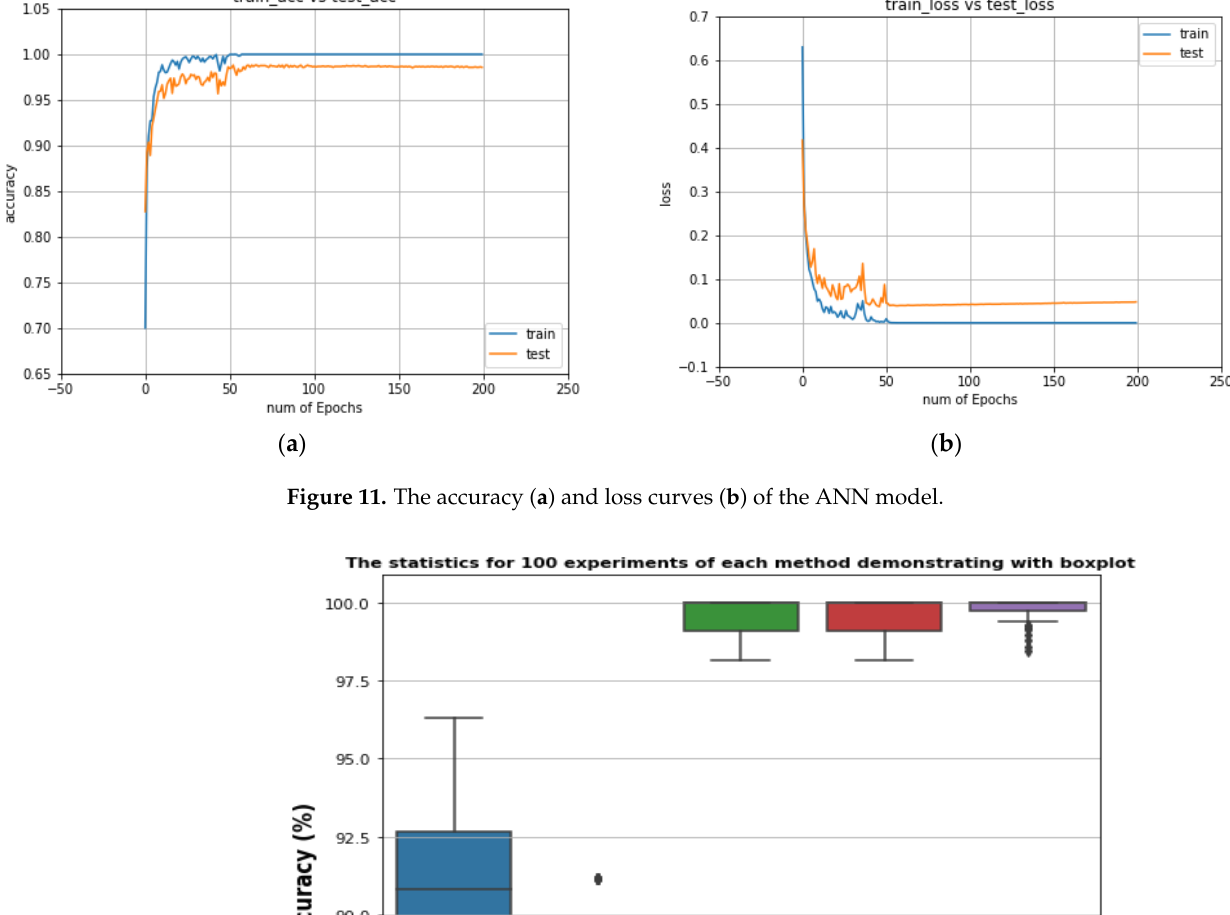
( c ) Figure 10. Confusion matrix of ( a ) RF, ( b ) XGB classifier, and ( c ) ANN.